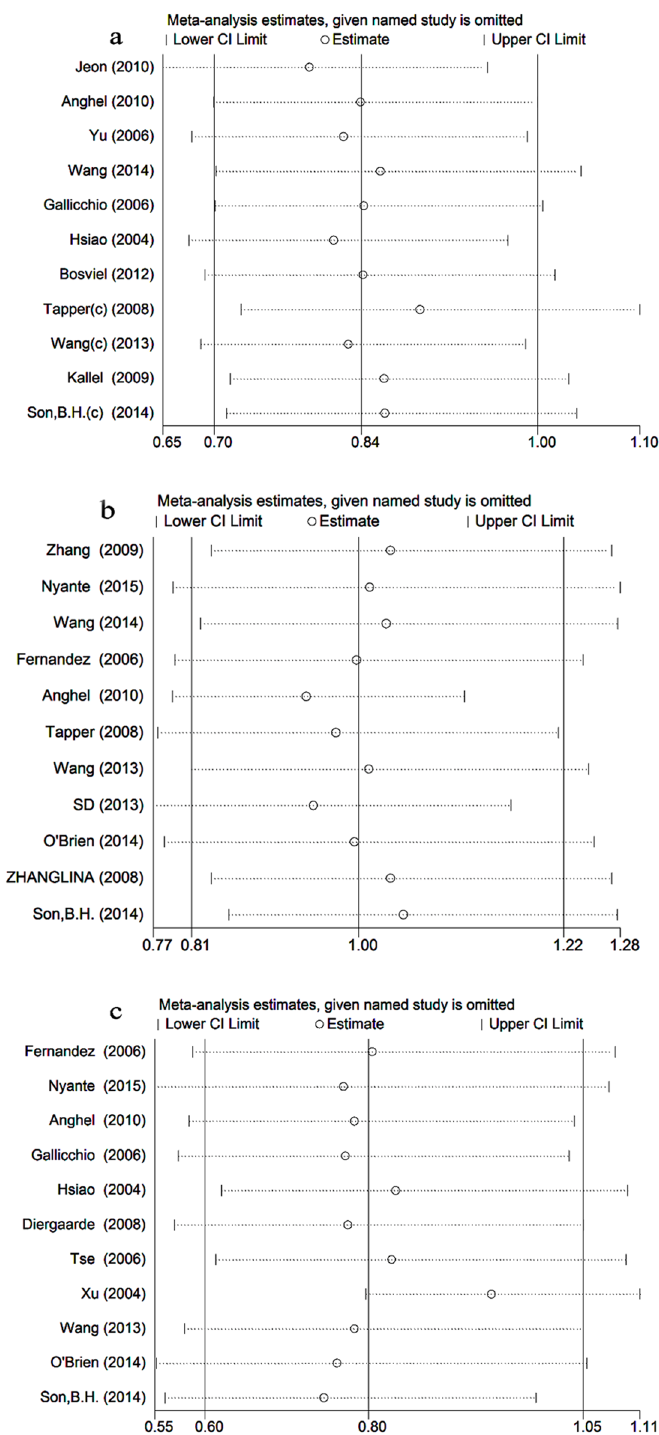
Fig 6. Sensitivity analysis of the meta-analysis of the association of the three ESR1 gene polymorphisms with breast cancer risk in the variant homozygote versus wild-type homozygote model. a Sensitivity analysis of rs2228480. b Sensitivity analysis of rs3798577. c Sensitivity analysis of rs2077647. The vertical axis indicates the overall OR, and the two vertical axes indicate the 95% CI. Every hollow round indicates the pooled OR when the left study was omitted from the